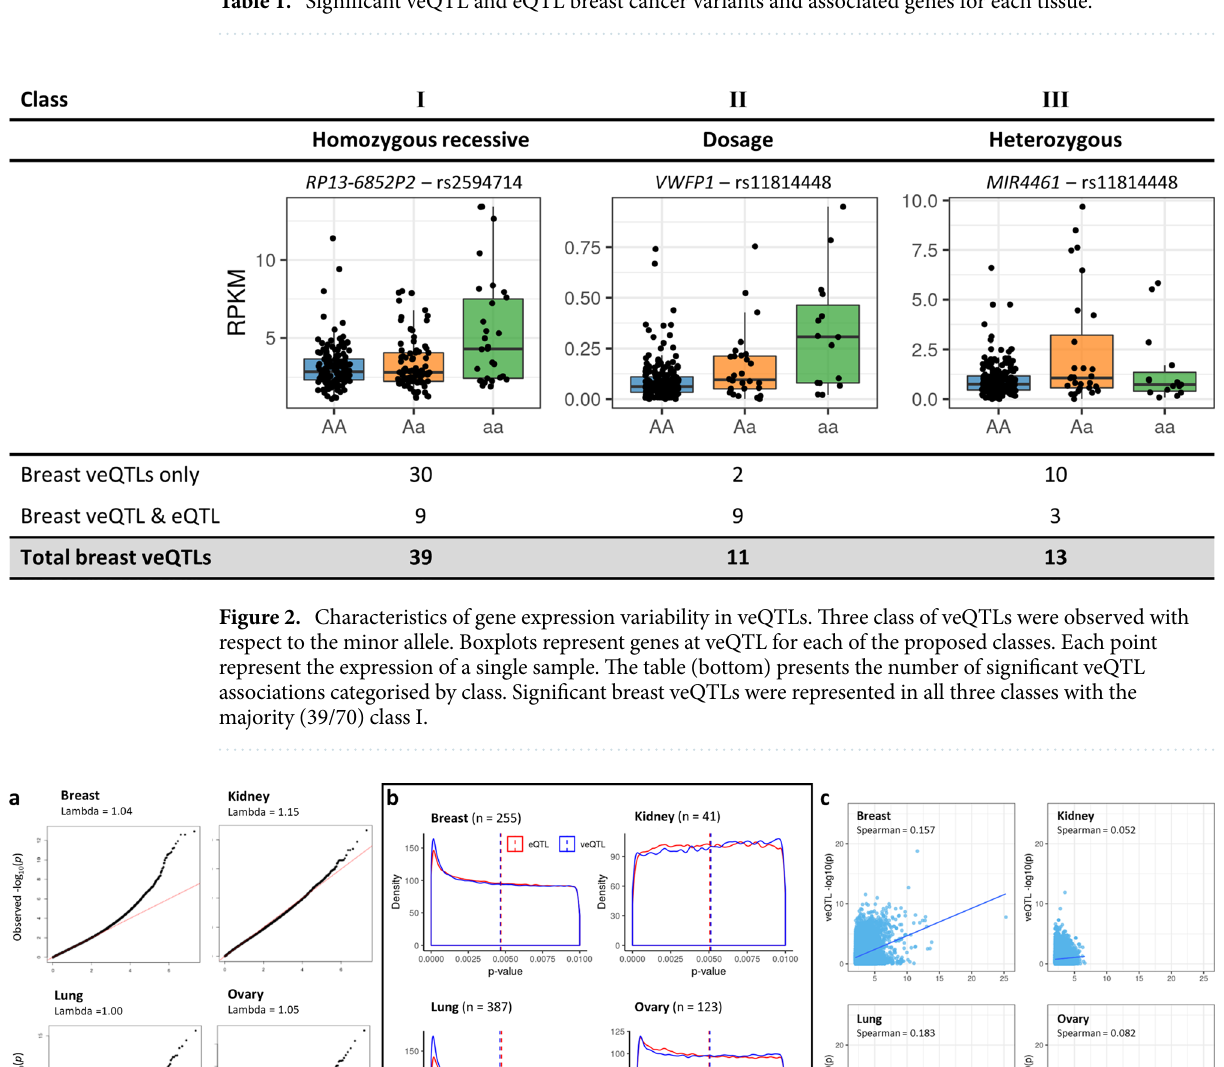
Table 1. Significant veQTL and eQTL breast cancer variants and associated genes for each tissue.